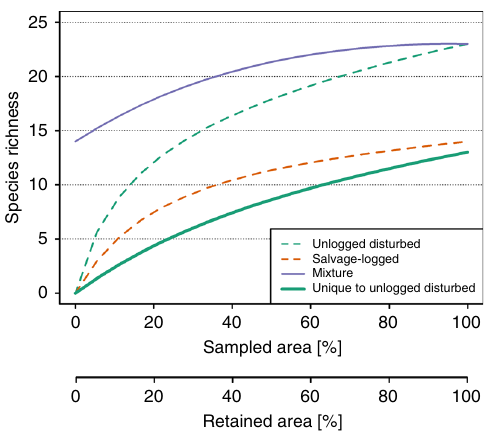
Fig. 1 Hypothetical example of mixed rarefaction/extrapolation. The example depicts species sampled in naturally disturbed but unlogged plots and naturally disturbed and salvage-logged plots. Unlogged plots (dashed green curve, upper x -axis) had a higher species richness rarefaction curve than salvage-logged plots (dashed orange curve, upper x-axis) across the proportion of sampled area. The solid purple curve represents the species richness for a given mixture of salvage-logged and unlogged plots when a proportion of disturbed area remains unlogged (lower x-axis). The richness of species that are unique to unlogged plots (solid green curve, lower x - axis; used in our analysis) increases with increasing proportion of unlogged disturbed plots in the mixture. Here only a mixture of two rarefaction curves is presented; see ref. 27 for a mixture including both rarefaction and extrapolation